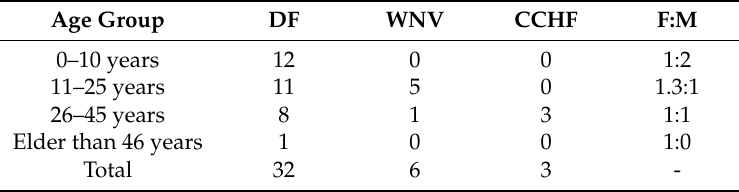
Table 2. Age and sex ratio of confirmed arboviral